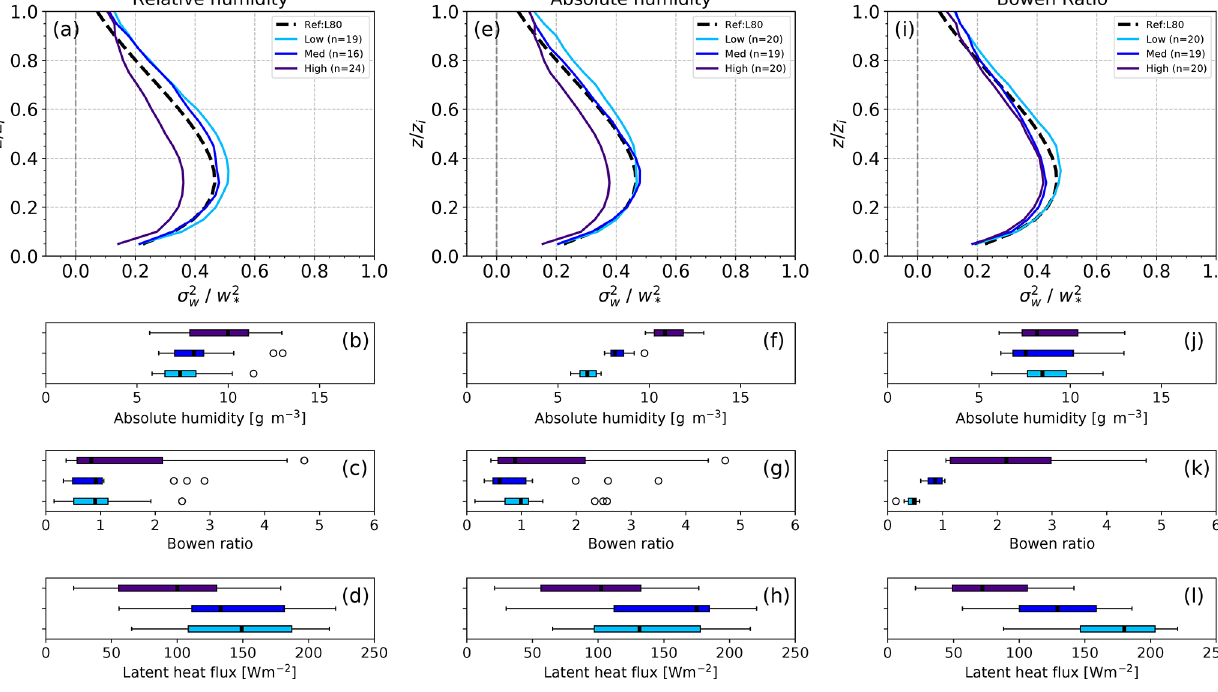
https://doi.org/10.5194/acp-23-4045-2023 Atmos. Chem. Phys., 23, 4045–4058,